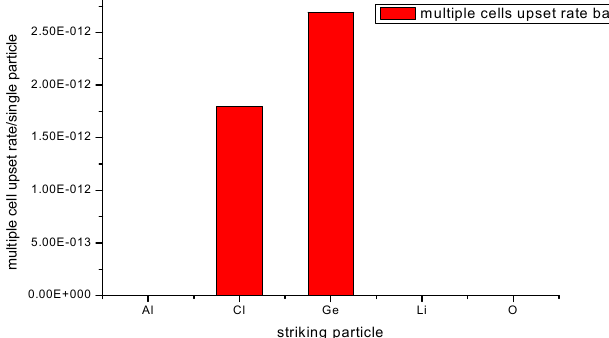
Figure 15. Multiple cell upsets (MCUs) versus particles for 512 Kbit SRAM with a 55AA pattern for normal incidence irradiation operated at 1.1 V.